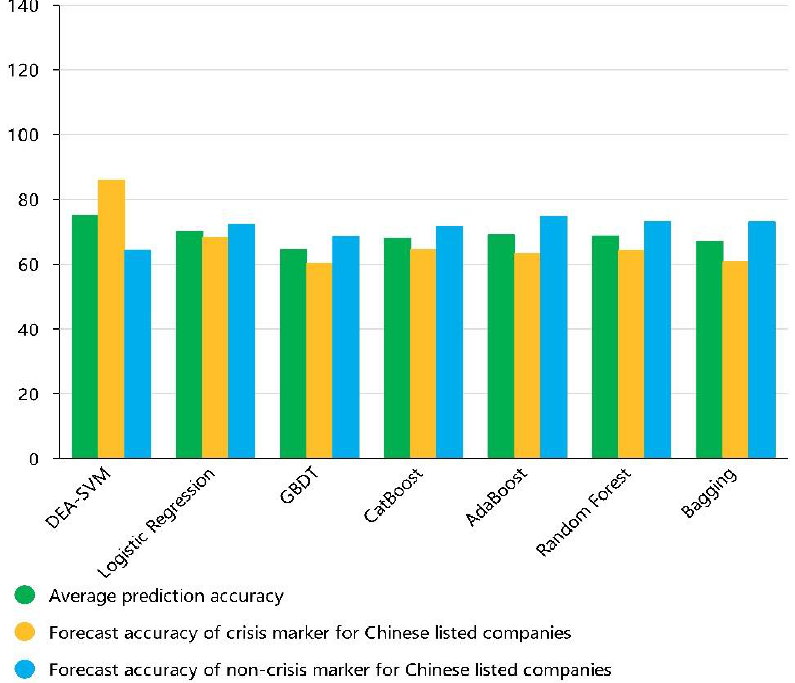
Figure 6. Comparison of early warning effects between six machine learning models and DEA–SVM model.